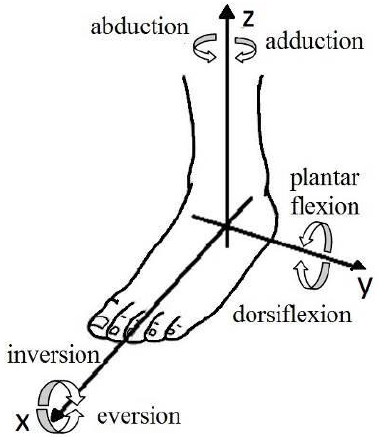
Figure 1. Ankle joint movements. Table 2. Ankle range of motion [29].